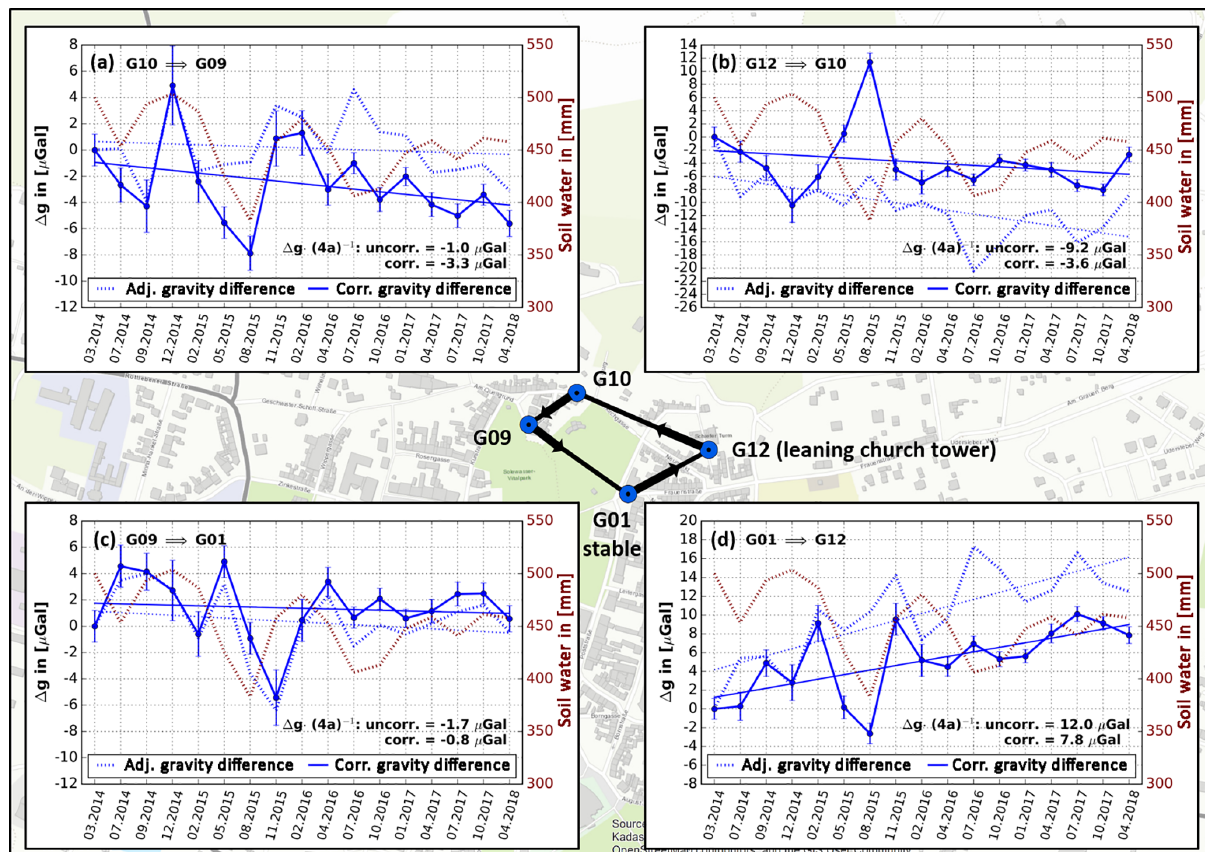
Figure 9. Selected adjusted gravity differences ( (cid:49)g , (cid:49)g xy = − (cid:49)g yx ) in the measurement network arranged in a rectangle consisting of gravity points G01, G12, G10, and G09, and corrected for soil water variations. (a) (cid:49)g G10–G09 reveals gravity decrease at G10, because G09 is stable within the SD. (b) (cid:49)g G12–G10 reveals faster gravity decrease at G12 than at G10, relative to each other. (c) (cid:49)g G09–G01 shows insignificant variations and reveals that also G09 is stable within the SD. (d) (cid:49)g G01–G12 shows a significant gravity decrease at G12 relative to G01, which is located next to the leaning church tower, because G01 is stable within the SD (cf. Fig.